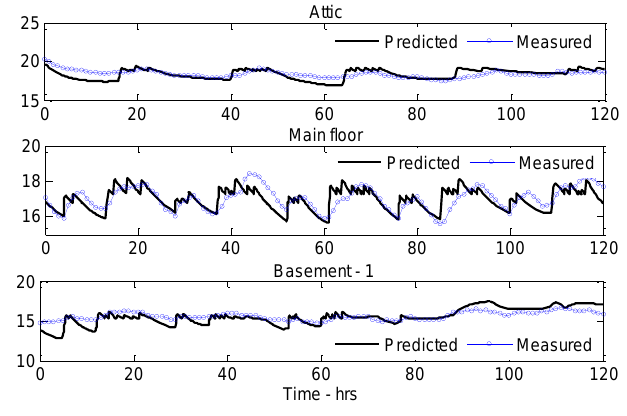
Figure 6: Variation of inside air temperature in the at- tic, main floor and basement-1 in the multi- room model [ 0 C].